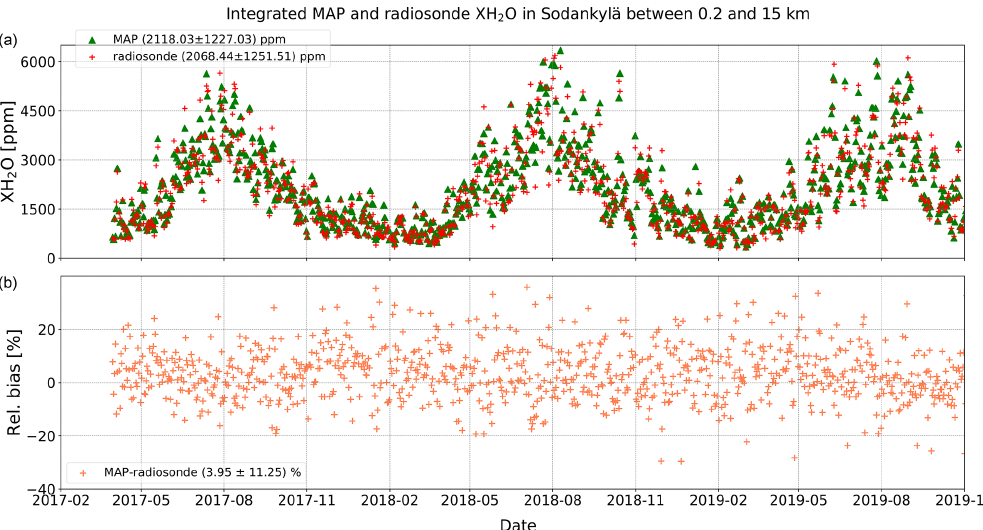
Figure 8. (a) Time series of integrated XH 2 O derived from MAP and radiosonde H 2 O VMR profiles between 0.2 and 15km. The corre- sponding relative biases are presented in panel (b)